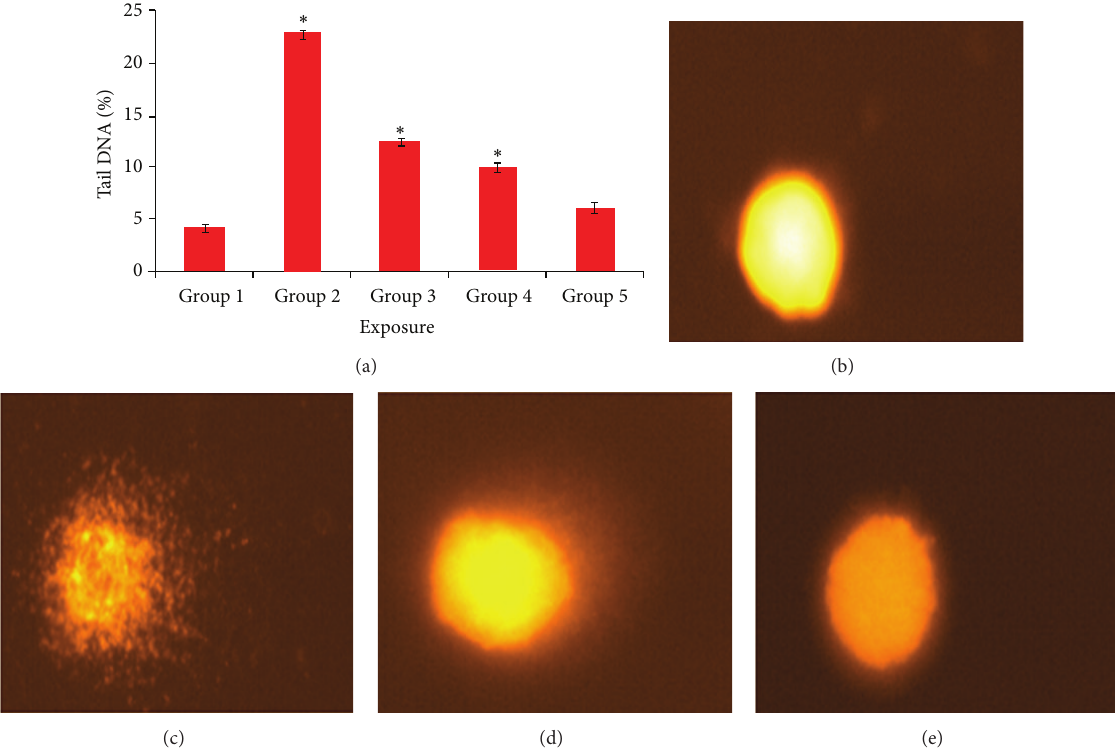
Figure 5: DNA damage in the lymphocytes after different exposures (a) % Tail DNA. (b) Group 1, (c) Group 2, (d) Group 3, and (e) Group 4. Each value represents the mean ± S.E. of three experiments. ∗ 𝑃 < 0.05 versus